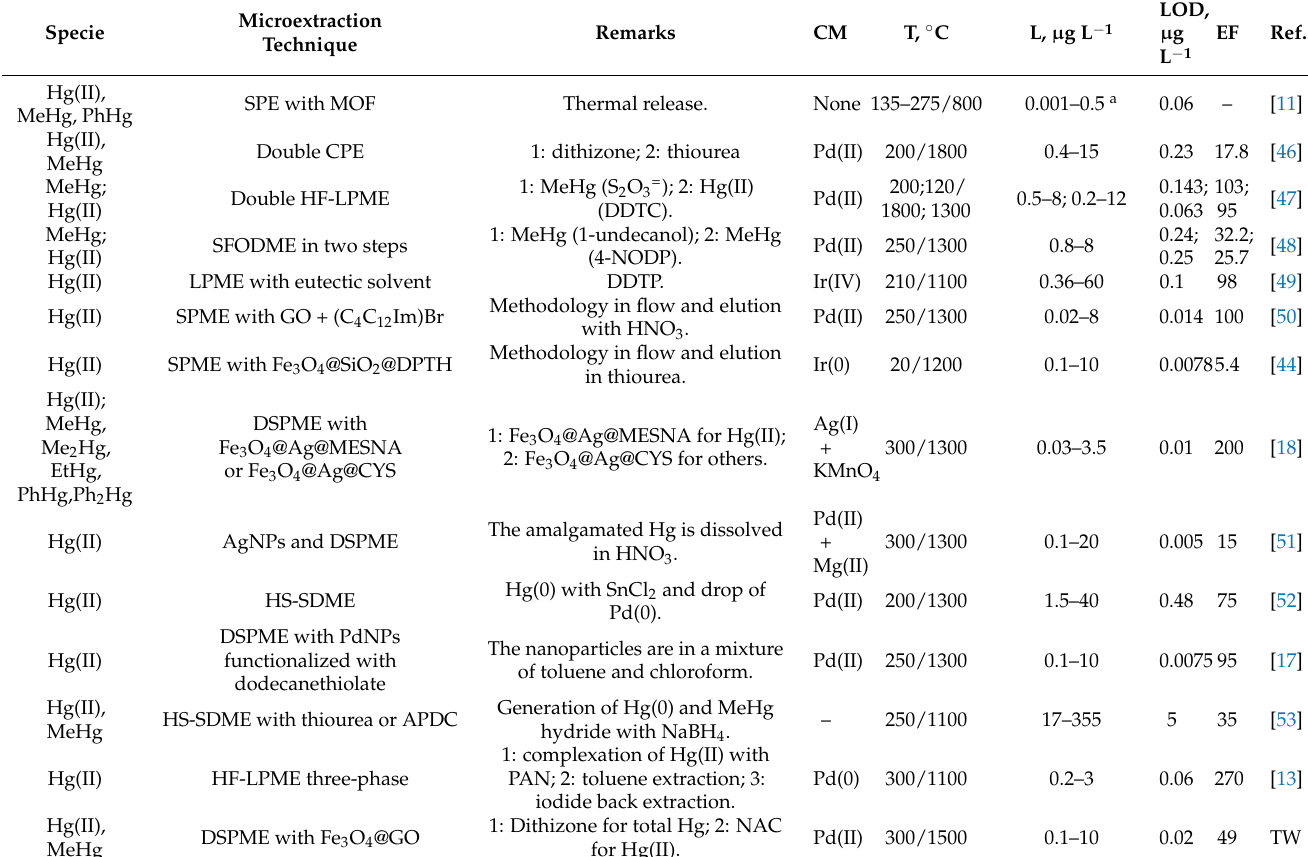
Table 5. Some recent procedures for ETAAS determination and/or speciation of mercury using microextraction